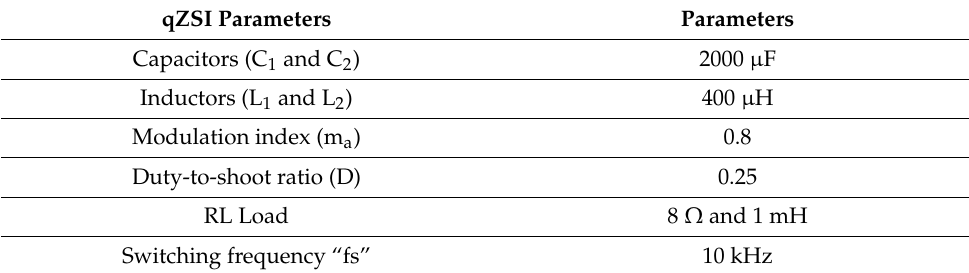
Table 10. Simulation parameters of